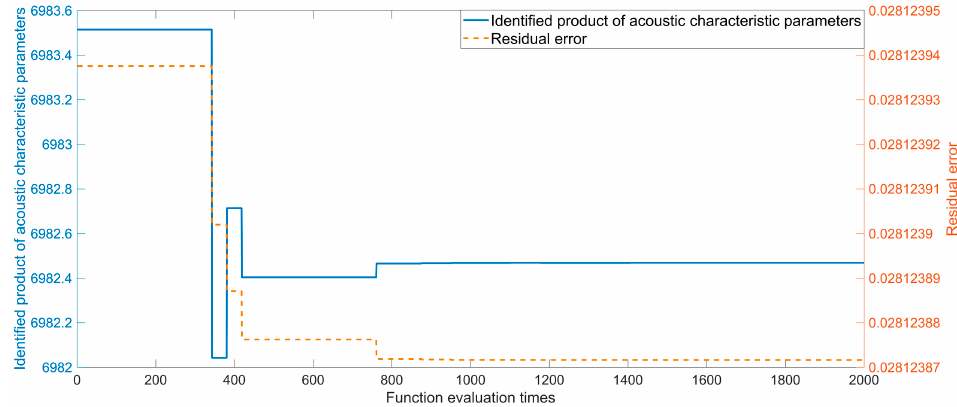
Figure 4. Optimization results of the cuckoo search identification algorithm.